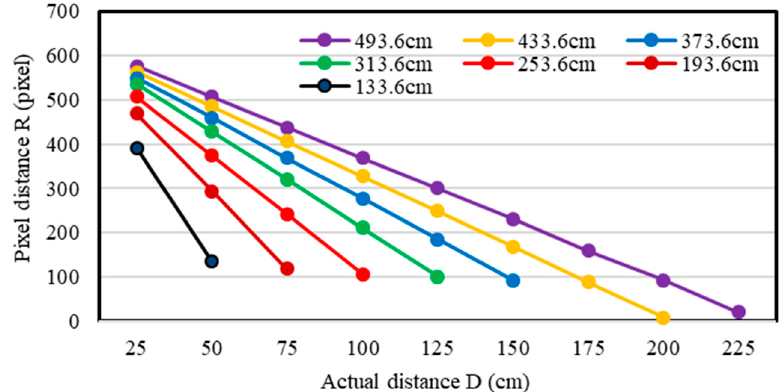
Figure 8. Distance relationship at different heights. The legend shows the actual distance from the